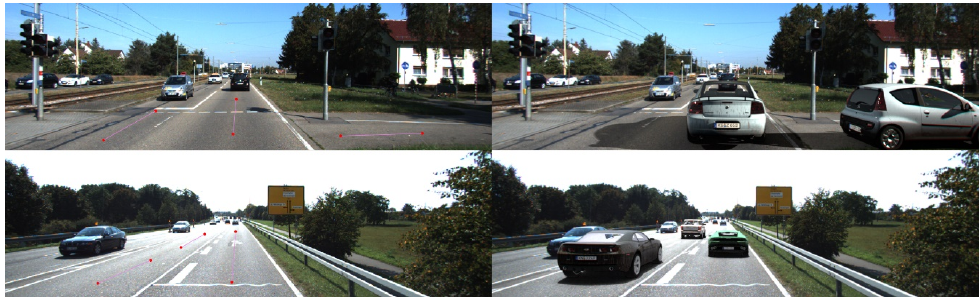
Figure 6. Marking trajectories on the original images ( left ) and augmenting image by rendered models at random positions on the trajectories ( right